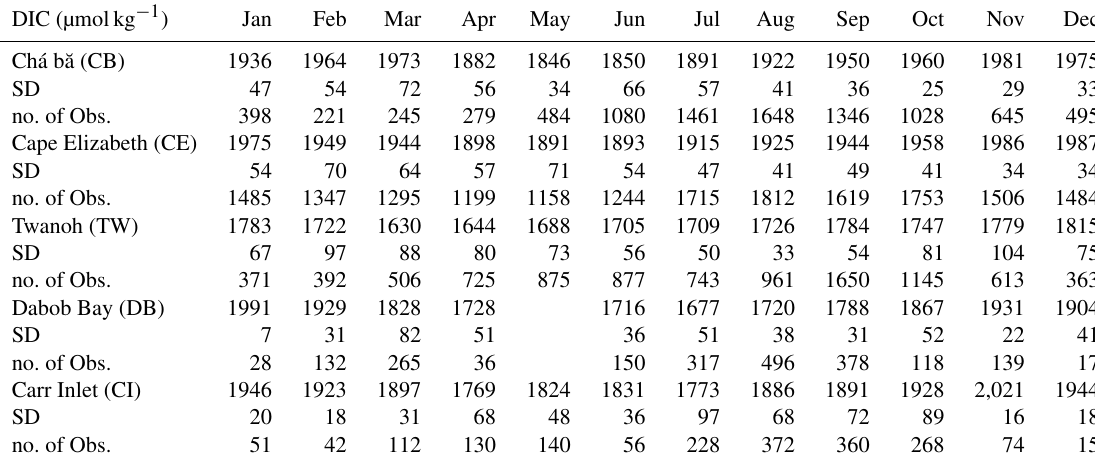
Table C4. Average monthly DIC seasonal cycles for the five Washington State moorings with sufficient observations to estimate DIC. The average monthly standard deviation (SD) and total number of observations (no. of Obs.) contributing to the monthly average estimate are included.